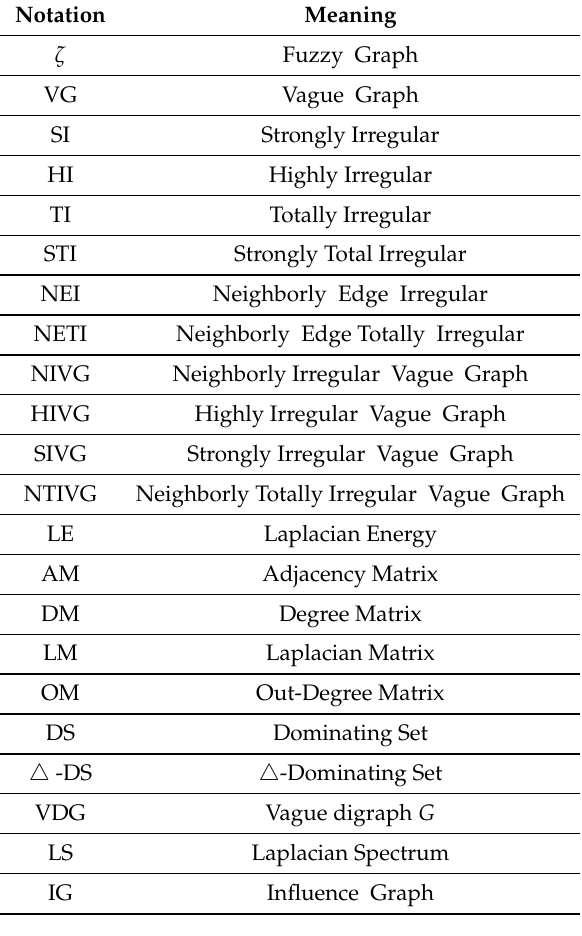
Table 1. Some basic